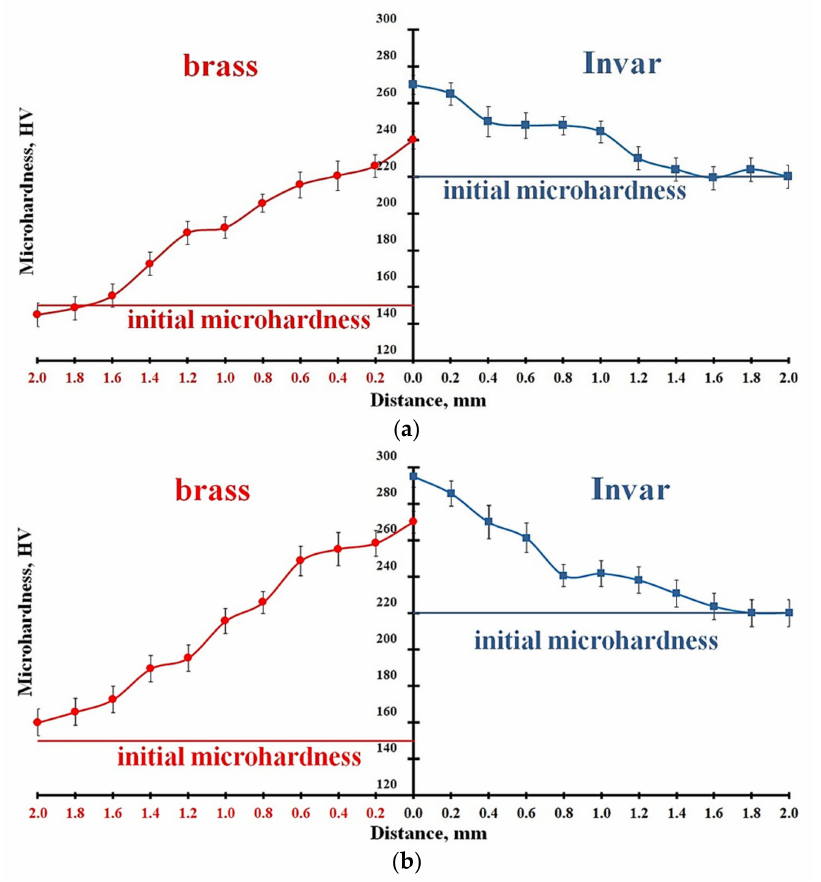
Figure 9. Distribution of microhardness on the weld interface cross-section: ( a ) initial part of bimetal; ( b ) final part of